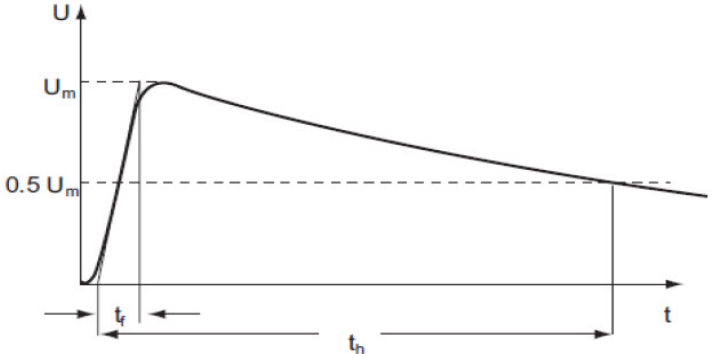
/ line by lightning strike